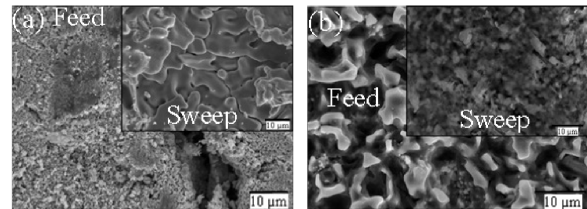
Fig. 11 SEM analysis of the feed and sweep side of the membranes after 100 h exposure to CO 2 and O 2 with 85%air/15%CO 2 at 875 ℃ : (a) 50CP–50PSFC and (b) 75CGCO–25LCF ceramic–carbonate membrane.